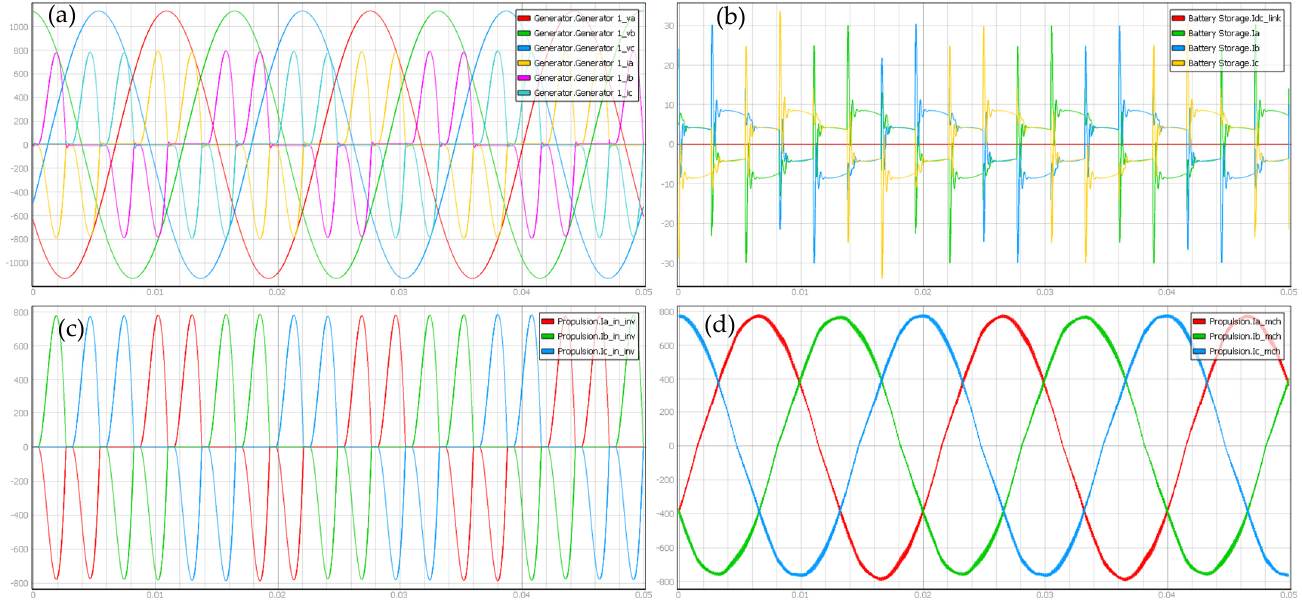
Figure 7. Results of case study 1/scenario A. From left to right, top to bottom: ( a ) diesel generator phase voltages and currents; ( b ) battery currents (at the battery itself and at the output of the filter); ( c ) input currents to the propulsion system; ( d ) stator currents of the induction motor.